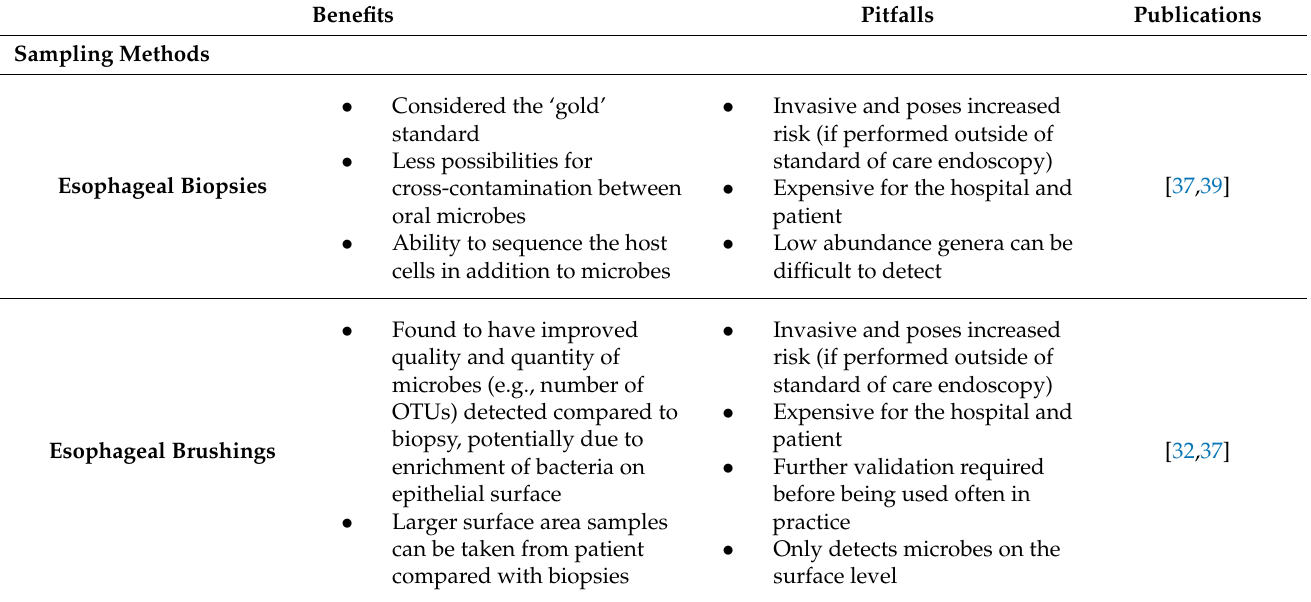
Table 1. Benefits and pitfalls of esophageal microbiome sampling methods and most common microbial sequencing methods. References provided for each